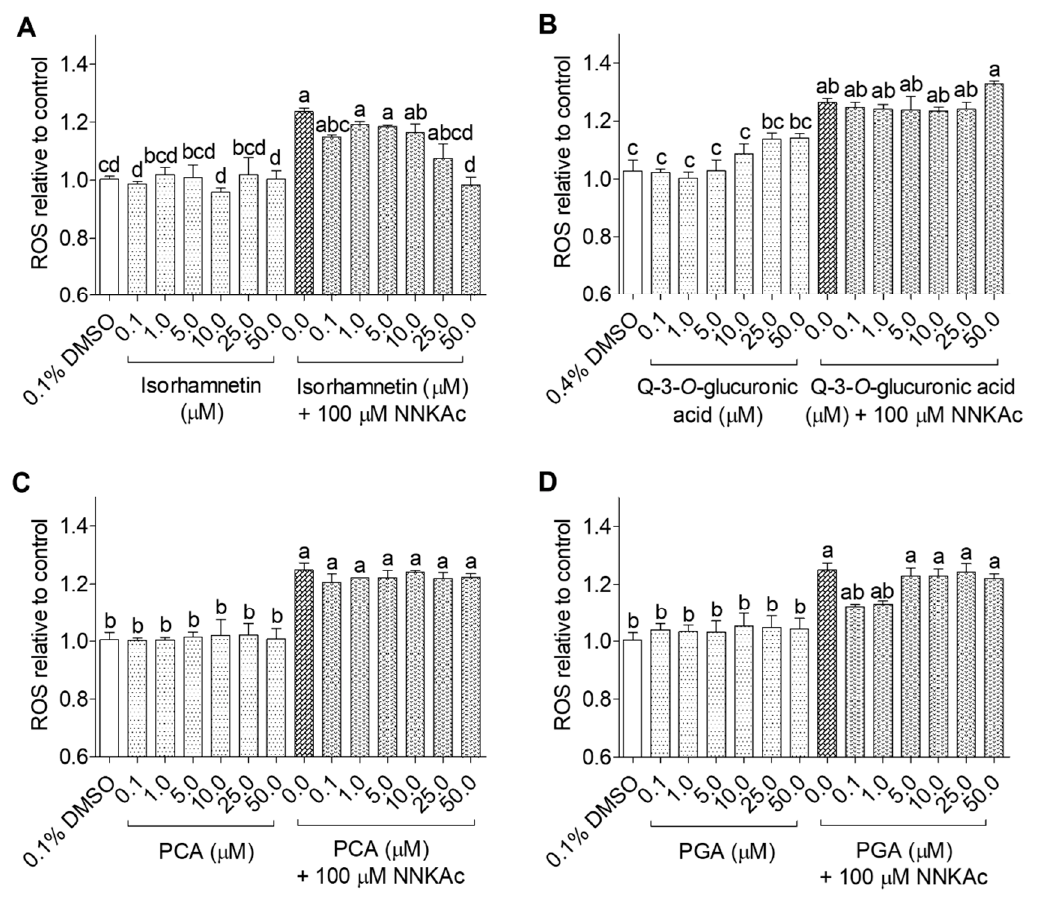
Figure 3. Effect of isorhamnetin ( A ), quercetin-3- O -glucuronic acid ( B ), protocatechuic acid ( C ), and phloroglucinaldehyde ( D ) on reducing NNKAc-induced ROS in BEAS-2B cells. Cells were pre-treated with concentrations ranging from 0.1 to 50 µ M of selected (poly)phenol metabolites for 3 h. Pre-treated cells were exposed to 100 µ M NNKAc for another 3 h to induce ROS generation. DMSO (0.1% or 0.4%) was used as the vehicle control. Effects on ROS levels were quantified using DCFDA fluorescence assay. Two independent studies ( n = 3) were performed, and results were expressed as mean ± standard deviation. Statistical analysis of data was performed by one-way ANOVA and mean comparison was done by Tukey’s mean comparison method ( α = 0.05) using Minitab 19 statistical software (LLC, Pennsylvania, USA). Mean values that do not share similar letters in bar graphs are significantly different ( p < 0.05). Abbreviations: NNKAc: 4-[(Acetoxymethyl)nitrosamino]-1-(3-pyridyl)-1-butanone, DCFDA: 2 ′ 7 ′ -dichlorofluorescein diacetate, ROS: reactive oxygen species, DMSO: dimethylsulfoxide, Q: quercetin, PCA: protocatechuic acid, PGA: phloroglucinaldehyde.